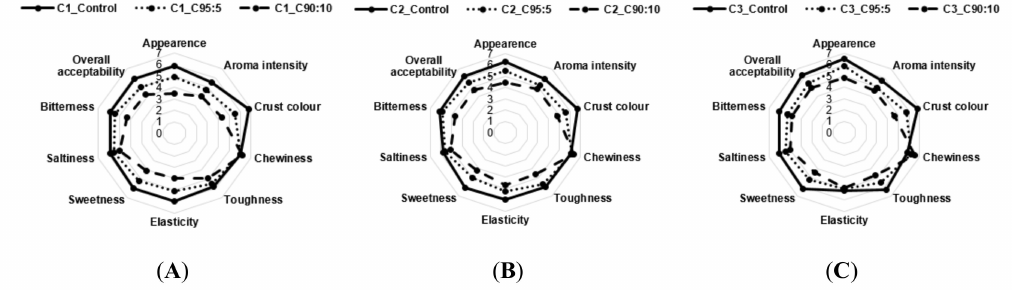
Figure 3. A sensory analysis of pizza with BSG addition and di ff erent type of flours. ( A ) Pizza with wheat flour 100% (C1_control), 95% wheat and 5% BSG composite (C1_95:5), 90% wheat and 10% BSG composite (C1_90:10) for the C1 sample; ( B ) Pizza with wheat flour 100% (C2_control), 95% wheat and 5% BSG composite (C2_95:5), 90% wheat and 10% BSG composite (C2_90:10) for the C2 sample; ( C ) Pizza with wheat flour 100% (C3_control), 95% wheat and 5% BSG composite (C3_95:5), 90% wheat and 10% BSG composite (C3_90:10) for the C3